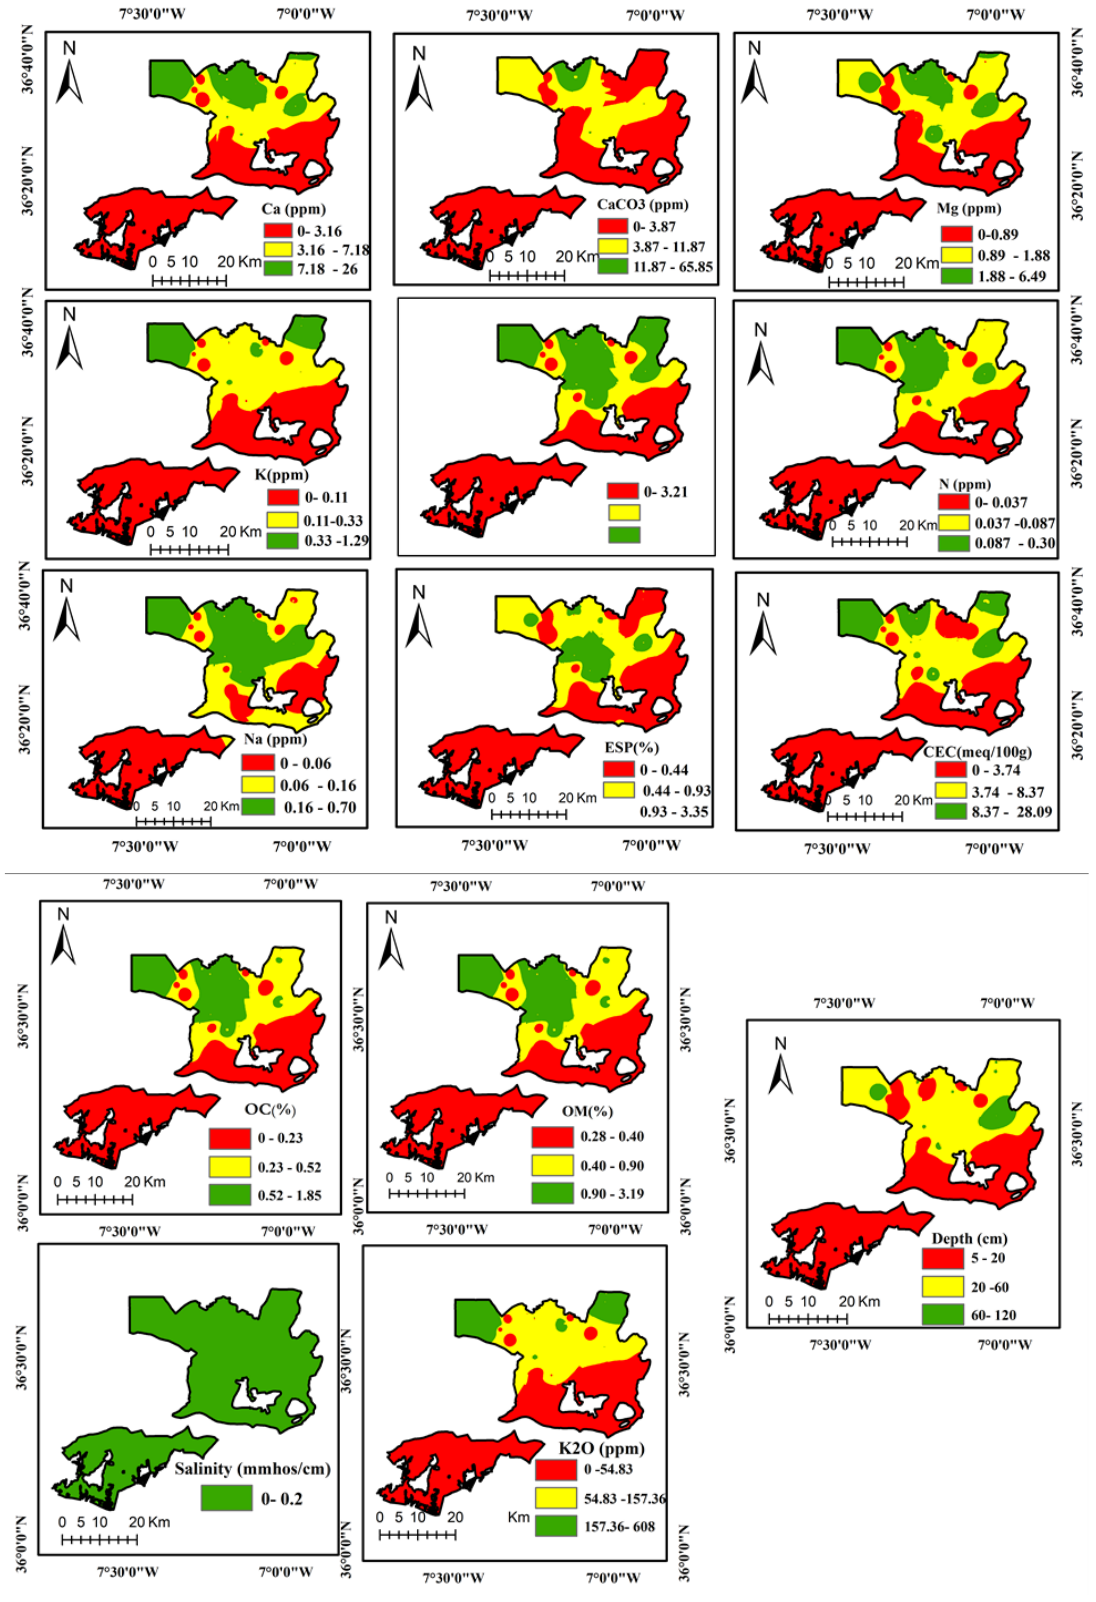
Figure 3. Physico-chemical Factors.